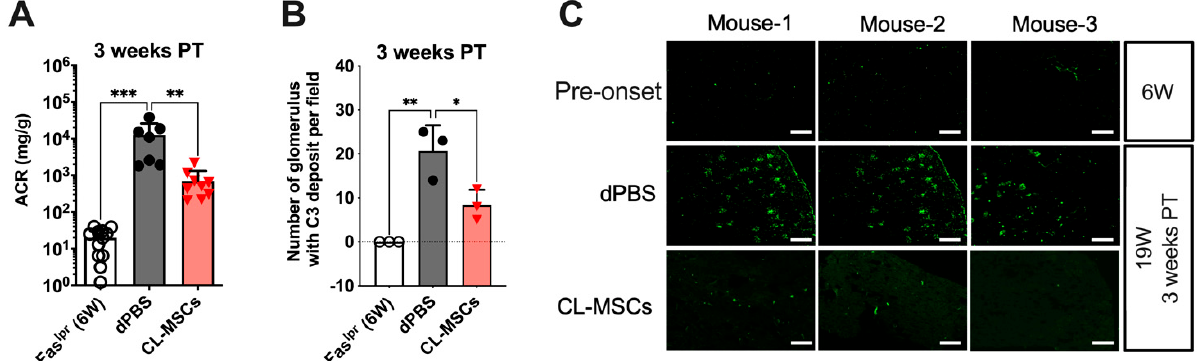
Figure 2. Kidney function was improved by CL-MSCs treatment: ( A ) Urinary ACR changes at three weeks PT. Twelve, 7, and 9 mice were used for 6-week-old pre-onset mice, dPBS control, and CL-MSCs. ( B ) The number of glomerulus with complement C3 deposition in the kidneys at three weeks PT (40-fold magnification). Three mice per group. ( C ) Representative image of complement C3 deposition. Green signals refer C3 deposition. Scale bar: 300 µ m. Six-week-old Fas lpr mice were used as a pre-onset control. Results were expressed as mean ± SD. For multiple comparison, the significance was defined as * p < 0.025; ** p < 0.005; *** p < 0.0005 when n = 2. One-way ANOVA Dunnett’s test was used for multiple comparison with 95% confidence